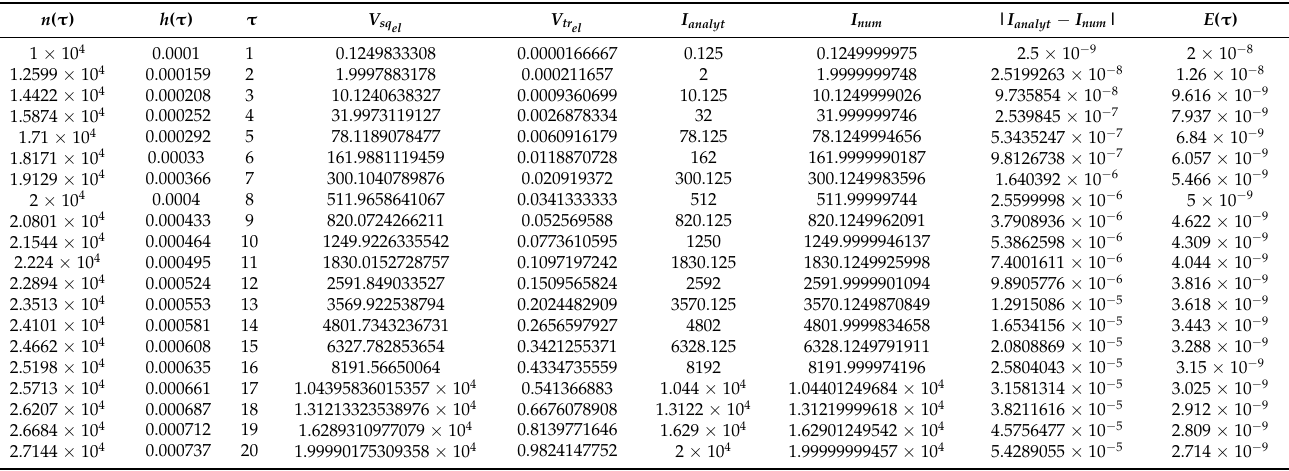
Table 3. Calculation of integral